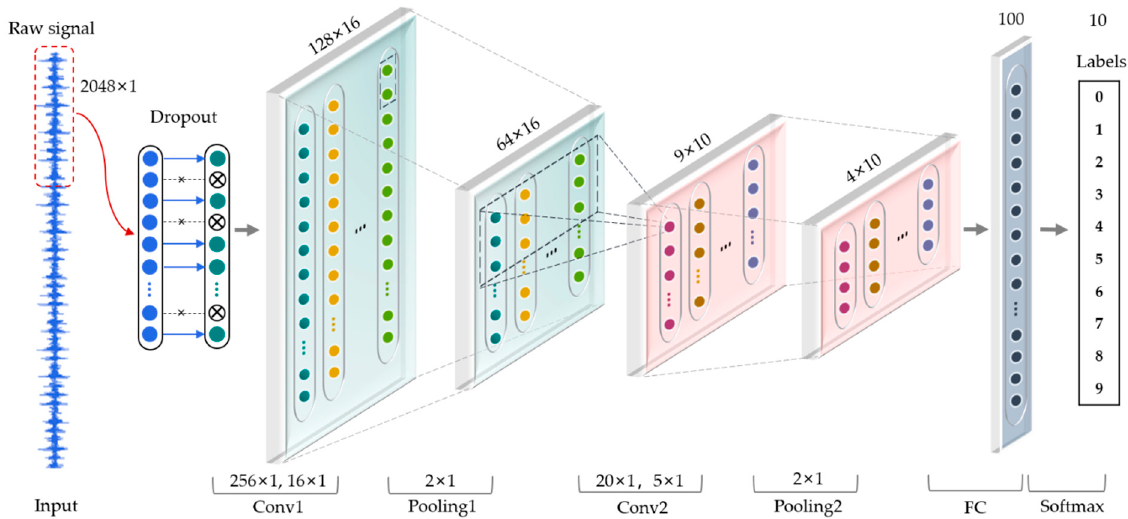
Figure 3. The architecture of one-dimensional convolutional neural network in this paper.